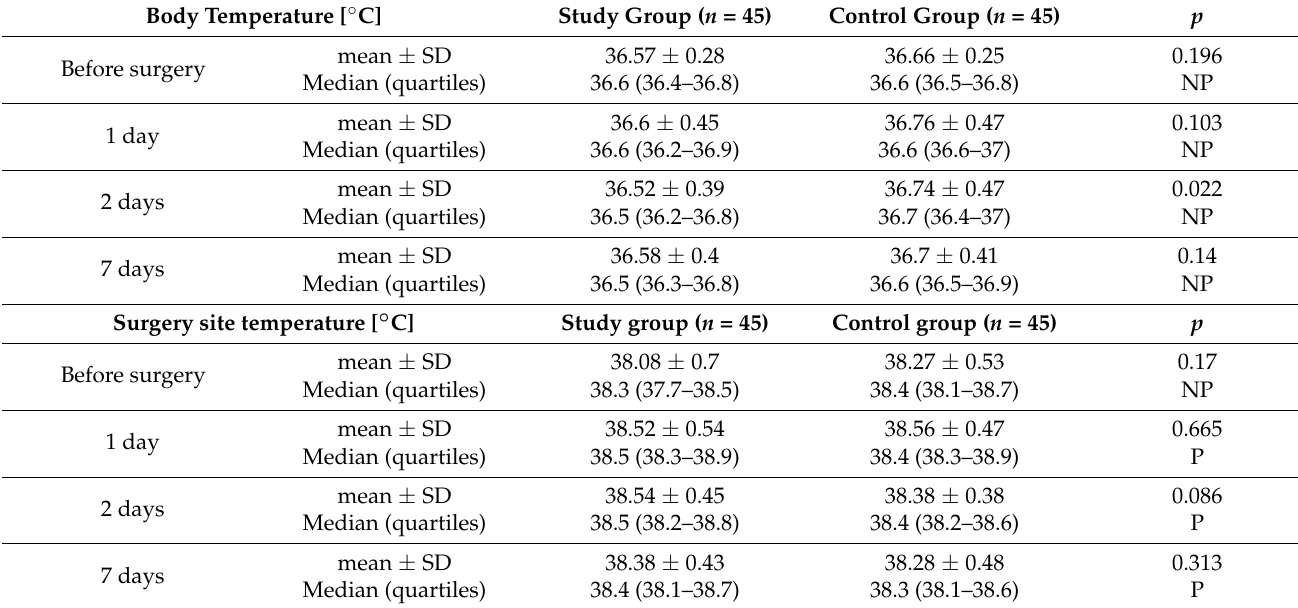
Table 7. Comparison of temperature values measured before surgery and on the 1st, 2nd, and 7th post-surgery days between the study and control